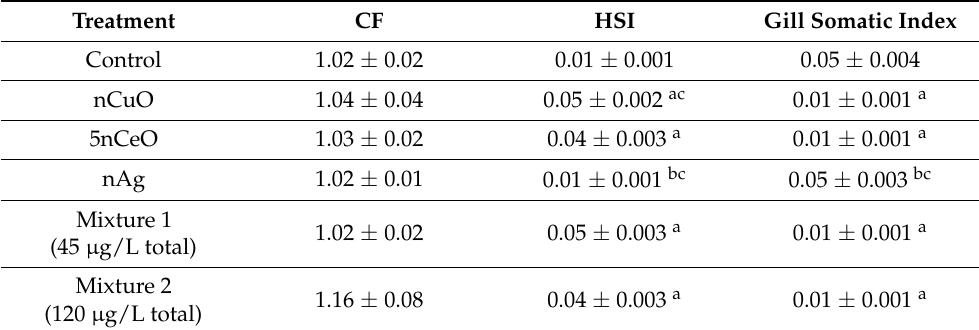
Table 2. Morphological characteristics of juvenile trout exposed to nanoparticle